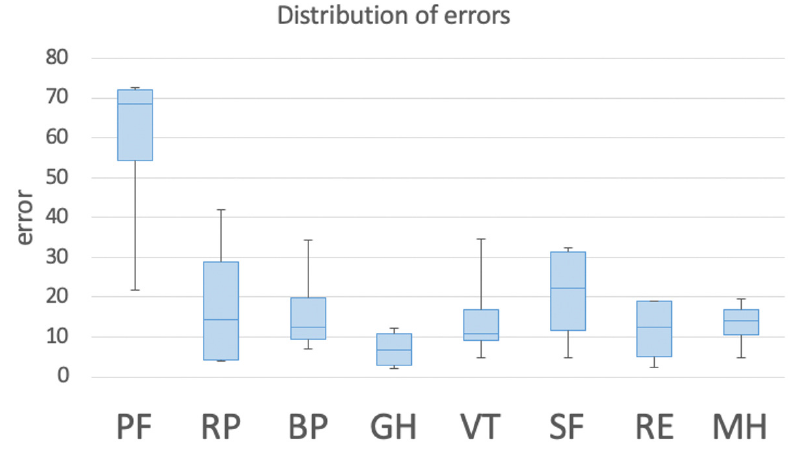
Figure 7. Distribution of errors between the estimated scores and the actual scores. The horizontal axis represents the eight QOL scales, and the vertical axis represents the distribution of the error (absolute value) between the estimated and actual scores. The distribution of error in the estimation of the score of the physical functioning scale, which is on the leftmost side of the graph, is remarkably large. A possible solution to this problem is changing the mapping between the PN score, which is a feature obtained from the text data, and the questionnaire response options. As a result of updating the mapping, the distribution of the estimation error is shown using a graph in Figure 8.